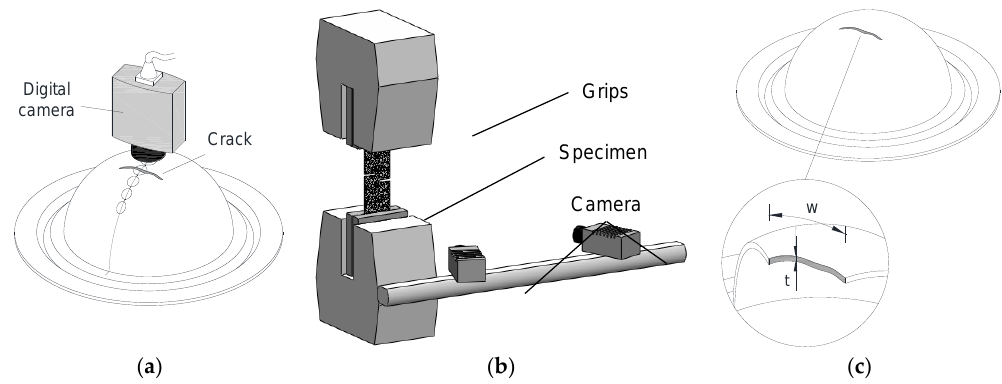
Figure 3. Schematic representation of ( a ) the computerised digital camera measuring system, ( b ) the digital image correlation system (DIC) and ( c ) the thickness measurements at the crack.